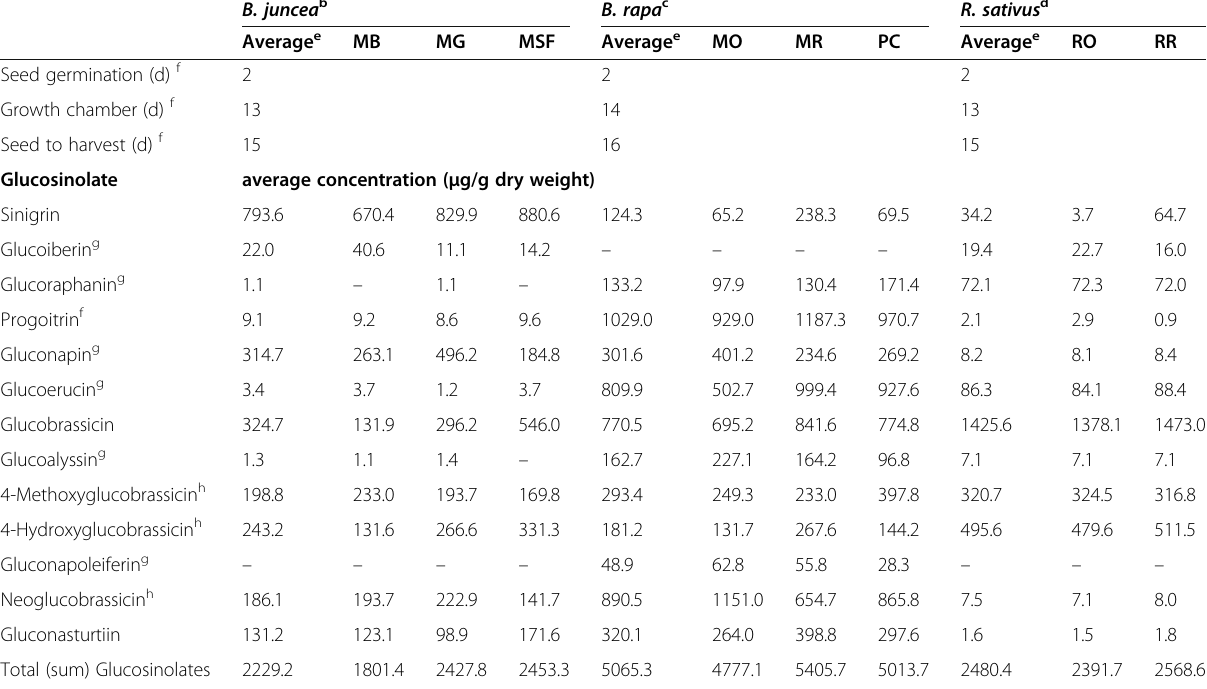
Table 1 Concentration of glucosinolates in each genus B. rapa, B. juncea and R. sativus under all combined treatments of amber, red and blue LED a